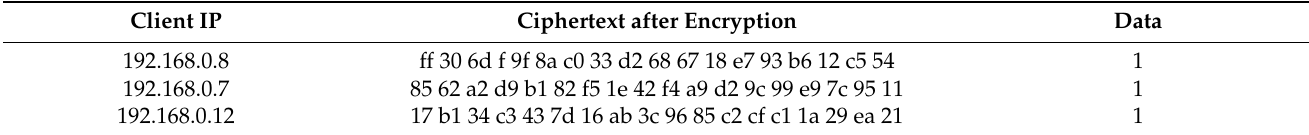
Table 3. Ciphertext received from the